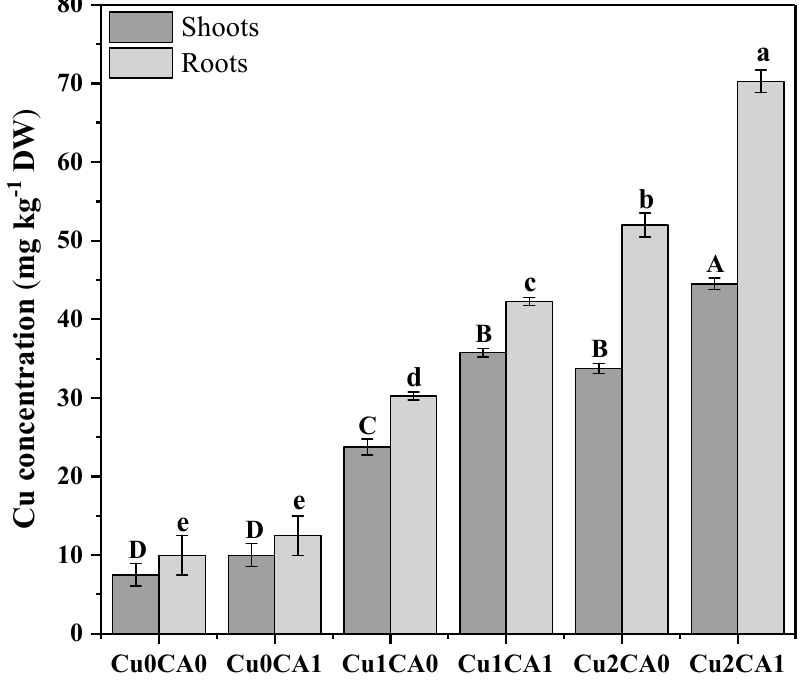
Figure 3. Cu uptake and accumulation by different plant parts (shoots and roots tissues) of C. capsularis seedlings under different levels of Cu in the nutrient solution with the exogenous supplementation of CA. Values are demonstrated as means of three replicates along with standard deviation (SD; n =3). One-way ANOVA was performed and means differences were tested by LSD ( p < 0.05). Different uppercase and lowercase letters on the error bars indicate significant differences between the treatments within shoots and roots, respectively. Cu 0 CA 0 (Cu = 0 μ M and CA = 0 mM), Cu 0 CA 1 (Cu = 0 μ M and CA = 2 mM), Cu 1 CA 0 (Cu = 50 μ M and CA = 0 mM), Cu 1 CA 1 (Cu = 50 μ M and CA = 2 mM), Cu 2 CA 0 (Cu = 100 μ M and CA = 0 mM), Cu 2 CA 1 (Cu = 100 μ M and CA = 2 mM). Table 2. E ff ect of citric acid (CA) application on bioaccumulation factor (BAF) and translocation factor (TF) of C. capsularis seedlings grown under di ff erent stress levels of Cu.